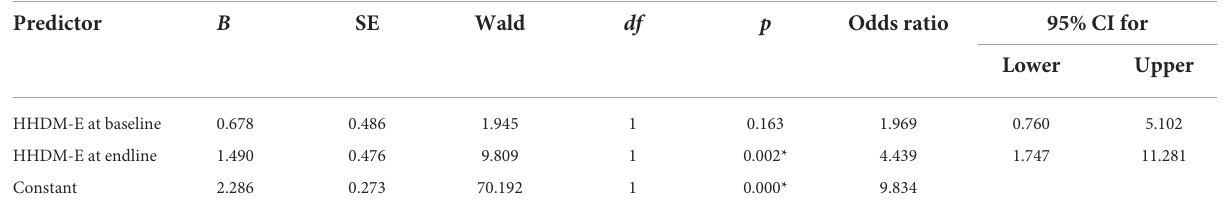
TABLE 4 Logistic regression results for egg consumption based on HHDM-E at endline. Logistic regression predicting likelihood of egg consumption based on HHDM-E at endline Predictor B SE Wald df p Odds ratio 95% CI for